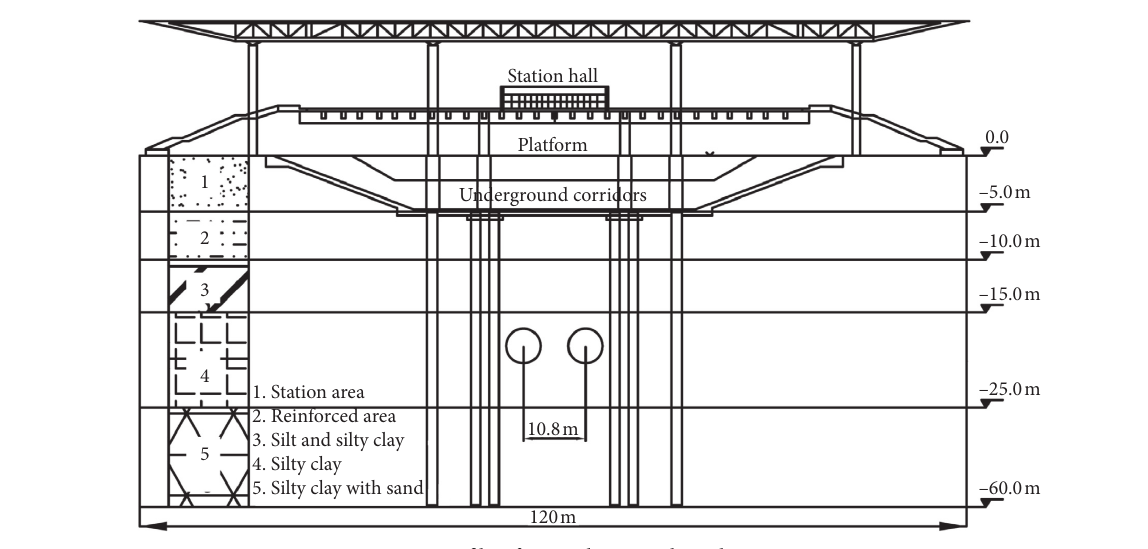
Figure 2: Profile of Hangzhou South Railway Station. Table 1: Main parameters of Herrick shield